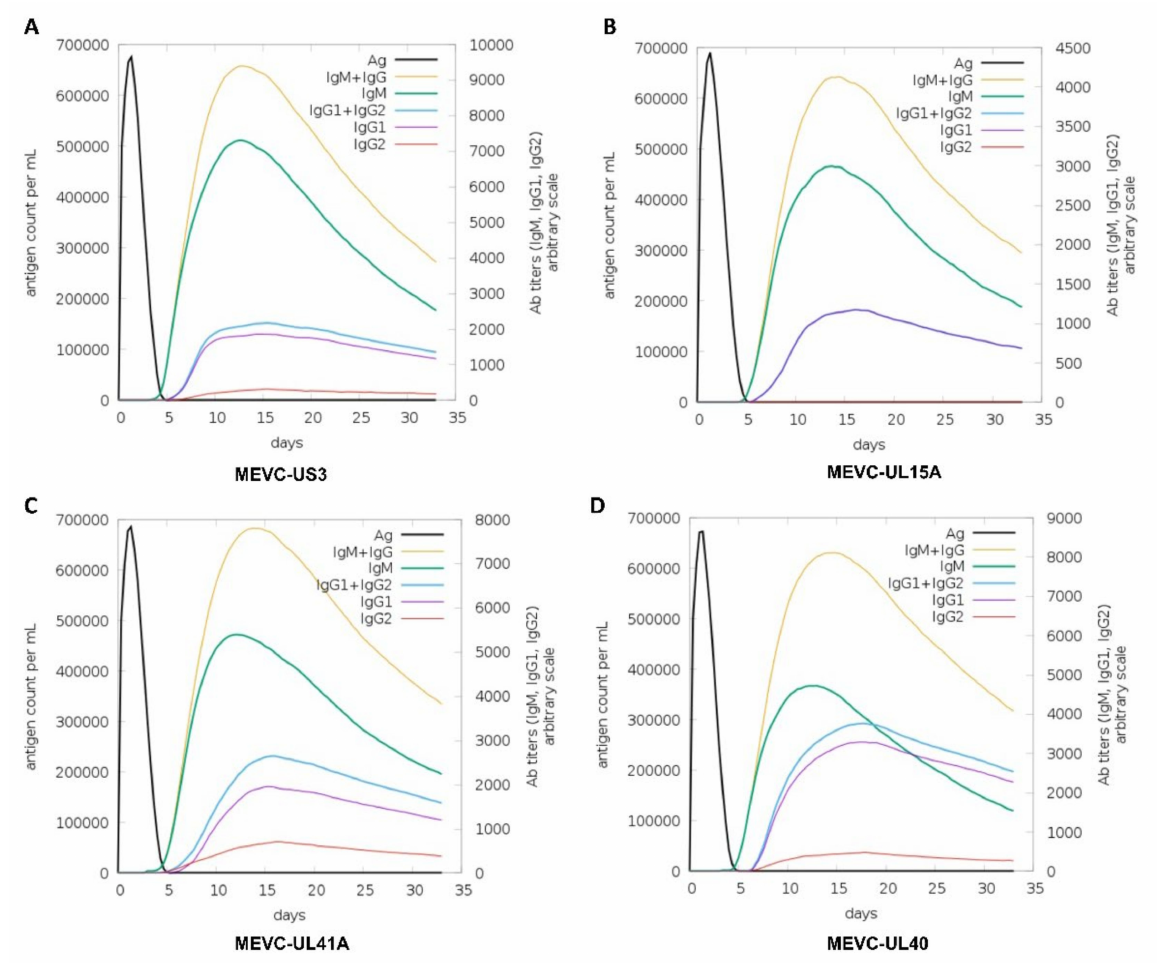
Figure 6. Represents the immune simulation graphs showing plotted antigen count/mL/day against Ab titers for each of the antigenic vaccine (MEVC) designs. ( A – D ) Represents the immune simulation graph for vaccines designed against each target protein of